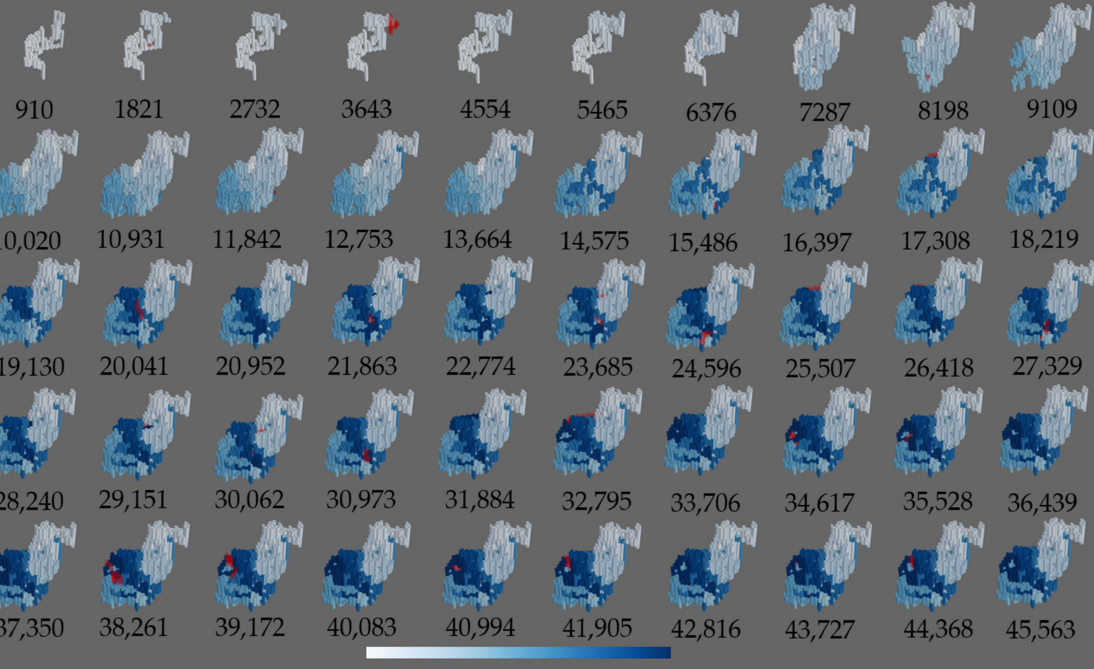
Figure 13. Scaffold growth visualization using blue color map for right Stanford bunny in Figure 6c with a total length of 14,405 bp, where the scaffold is represented as cylinders. The total iteration of the shape annealing schedule is divided equally into 50 steps, where an image is generated at each step. The blue color map starts from a light blue tint, which represents the beginning of the scaffold, to dark blue tint, which represents the end of the scaffold. Below each image is the iteration number during the annealing schedule. The transparent red cylinders signify the application of the reversal